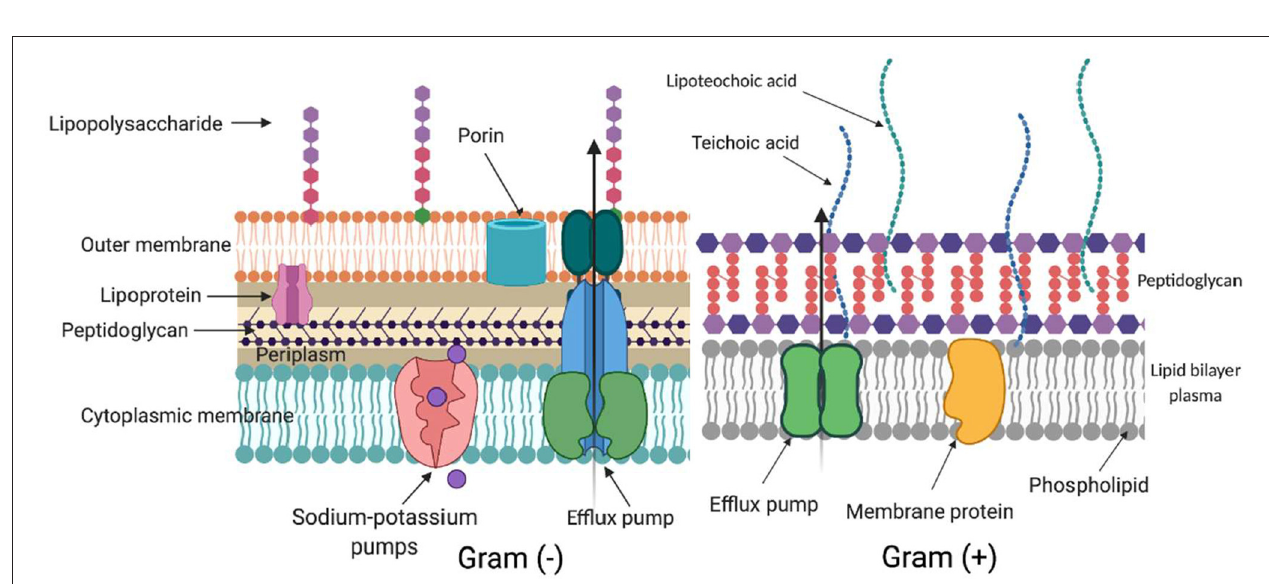
FIGURE 2 | Differences in cell wall structure in gram-negative and gram-positive bacteria. Schematic representation of a cell wall in gram-negative [Gram (–)] and gram-positive [Gram ( + )] species. The complex structure of two lipid membranes: cytoplasmic and an outer membrane are responsible for generally lower aPDI effectiveness against gram-negative bacteria. On the contrary, gram-positive species with their thick although relatively porous peptidoglycan are more easily photoinactivated. The main elements in the cell wall that can be involved in photodynamic inactivation are depicted. (Created with BioRender).